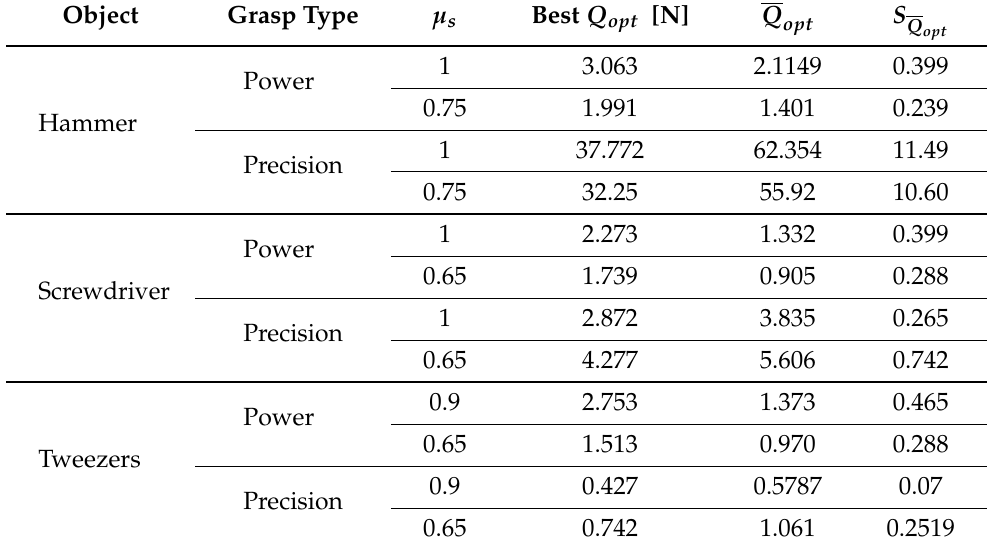
Table 3. Optimal grasp quality